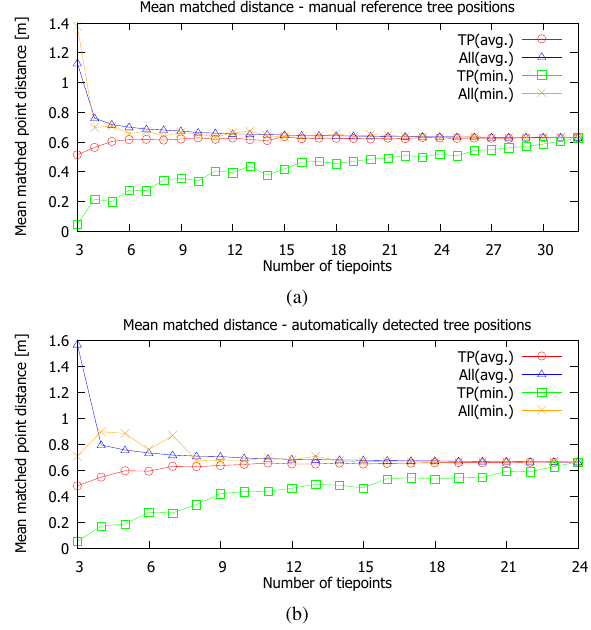
Figure 8: Mean coregistration distance on tiepoints (TP) and all matched points (All) for real data when true correspondences are known, by tiepoint set size uates the real-world application with no prior knowledge of cor- respondences. The final mean matched distances of the set of all matched points (all) and tiepoints only (TP) are depicted in